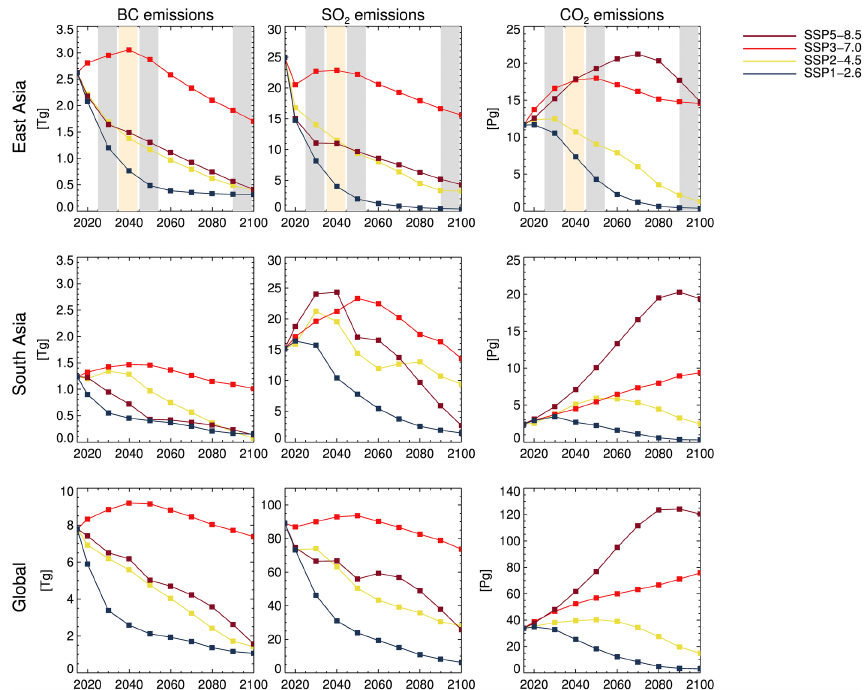
Figure 1. Time series of total emissions for BC, SO 2 (Tg), and CO 2 (Pg) in SSPs 1–2.5, 2–4.5, 3–7.0, and 5–8.5 from East Asia, South Asia, and the globe. Periods used in analyses are highlighted in the panels of the first